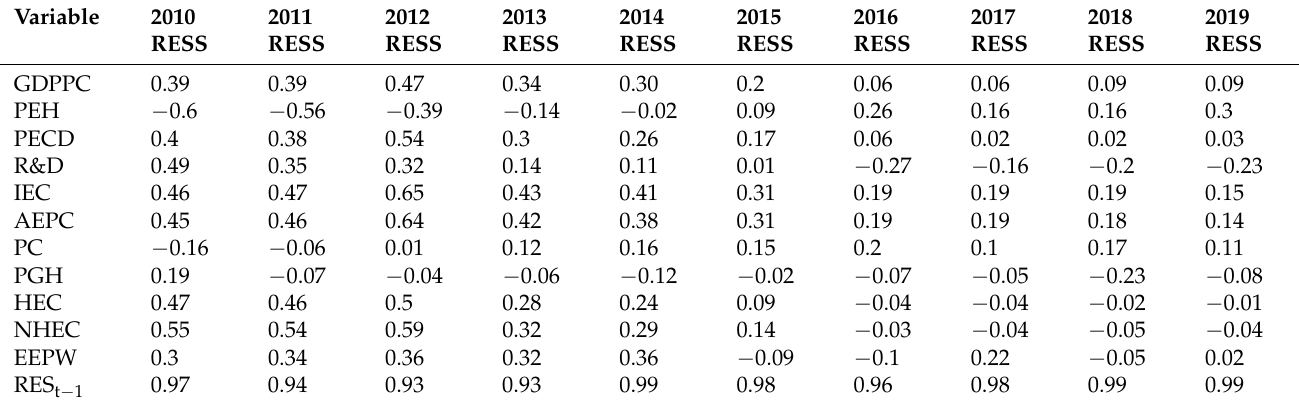
Table 3. The correlation between exogenous variables and the endogenous variable in